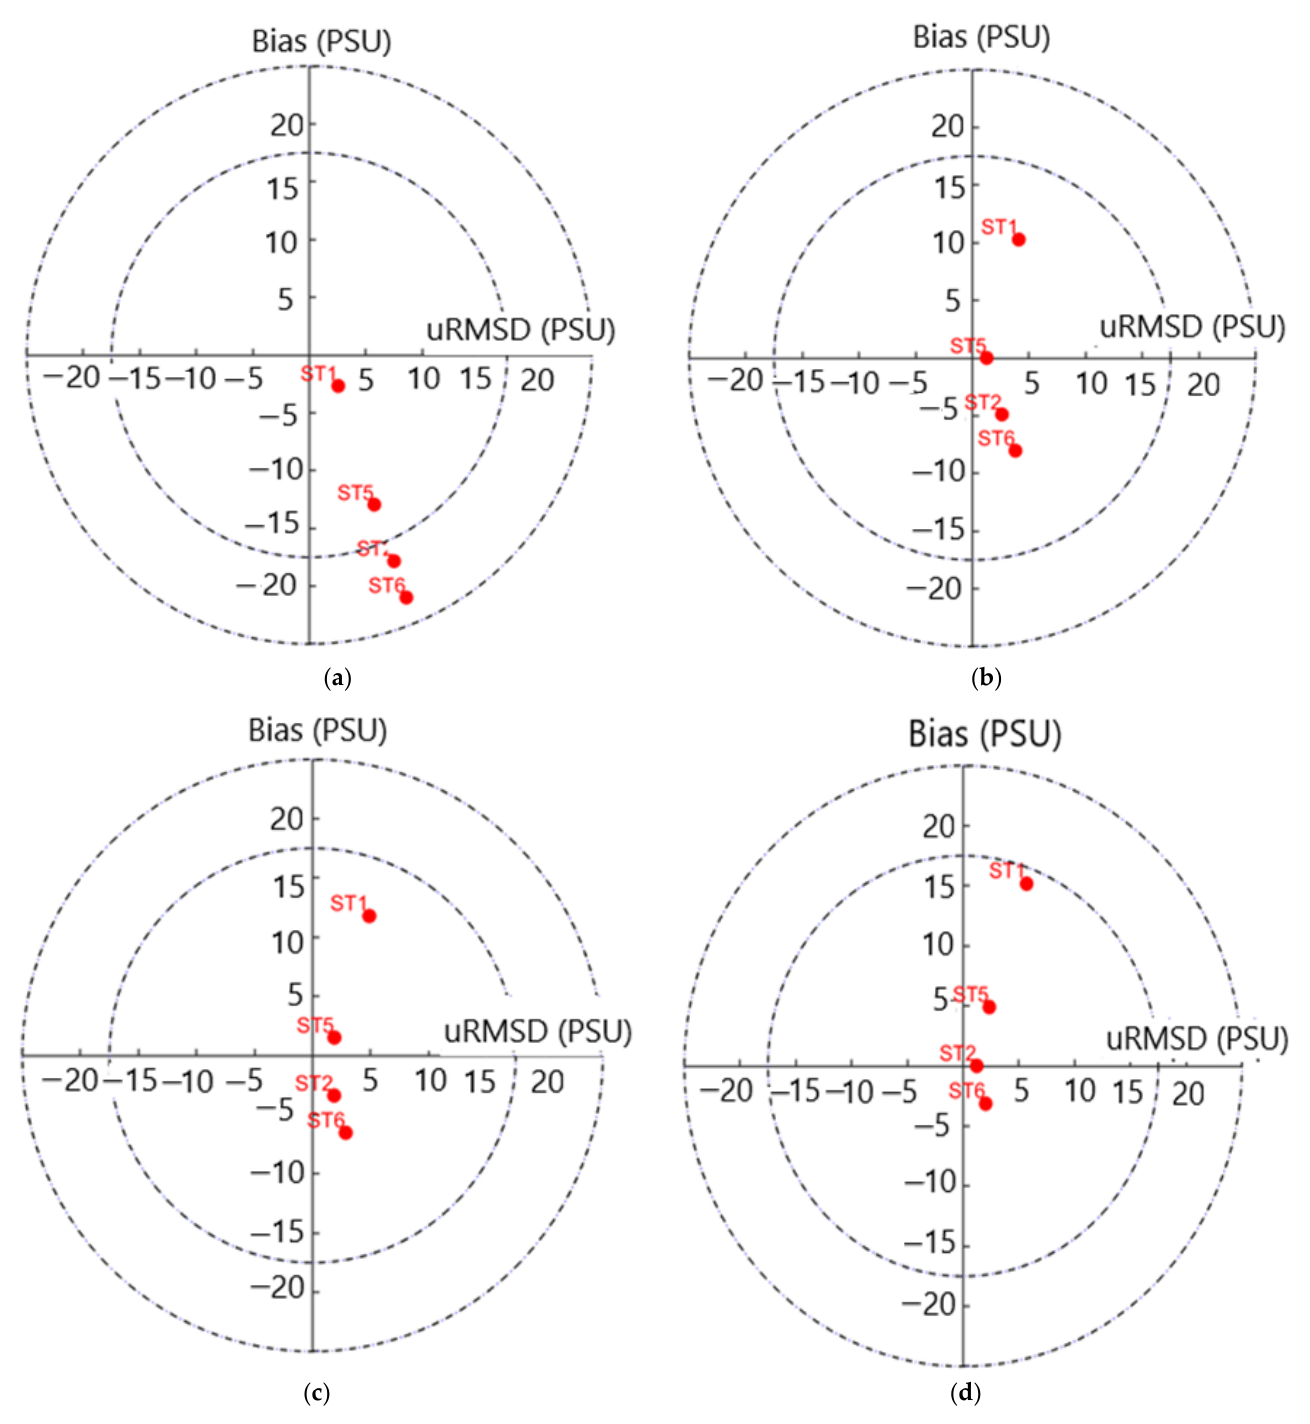
Figure 7. Target diagrams for salinity for St1 ( a ), St2 ( b ), St5 ( c ), and St6 ( d ).